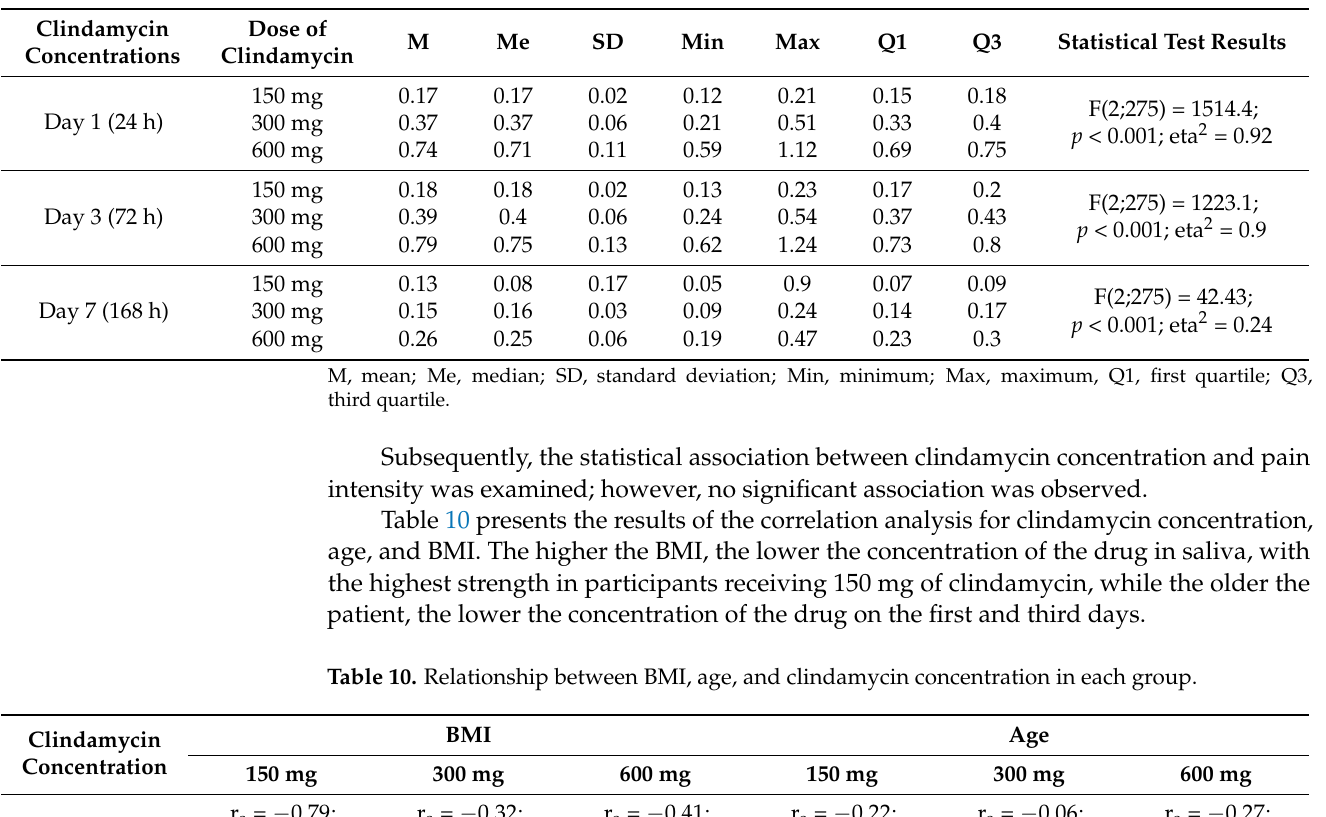
Table 9. Concentrations of clindamycin in the study groups based on individual time frames.